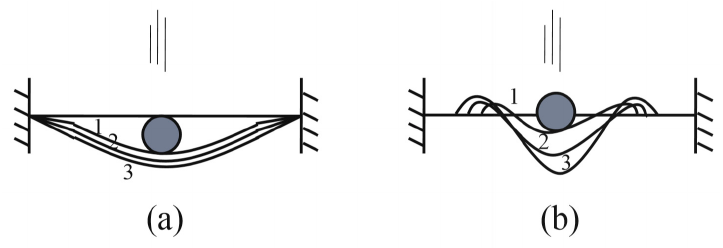
Figure 12. Varying response ( a ) boundary and ( b ) wave [79].